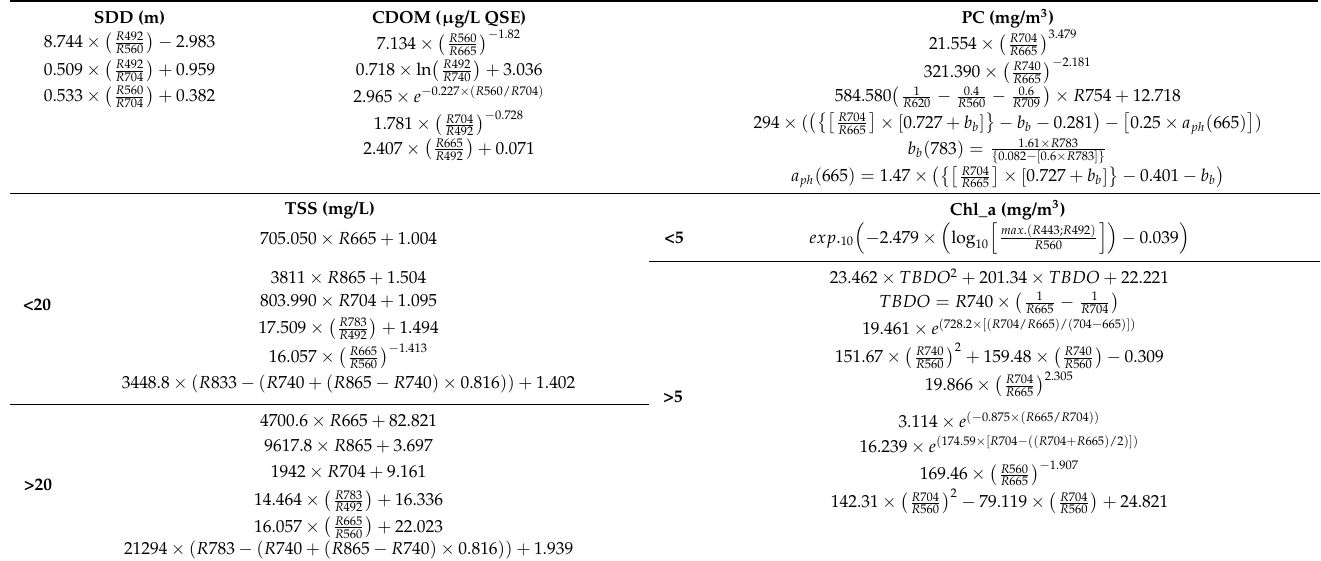
Table 2. In situ spectrometry water quality algorithms tested for each water quality